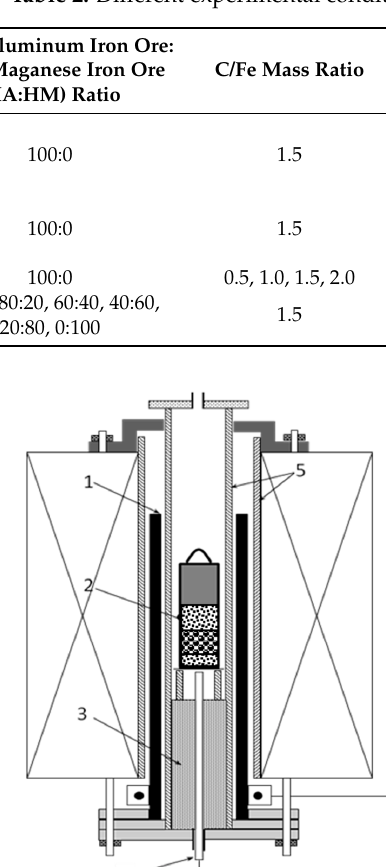
Table 2. Different experimental conditions of the reduction tests.